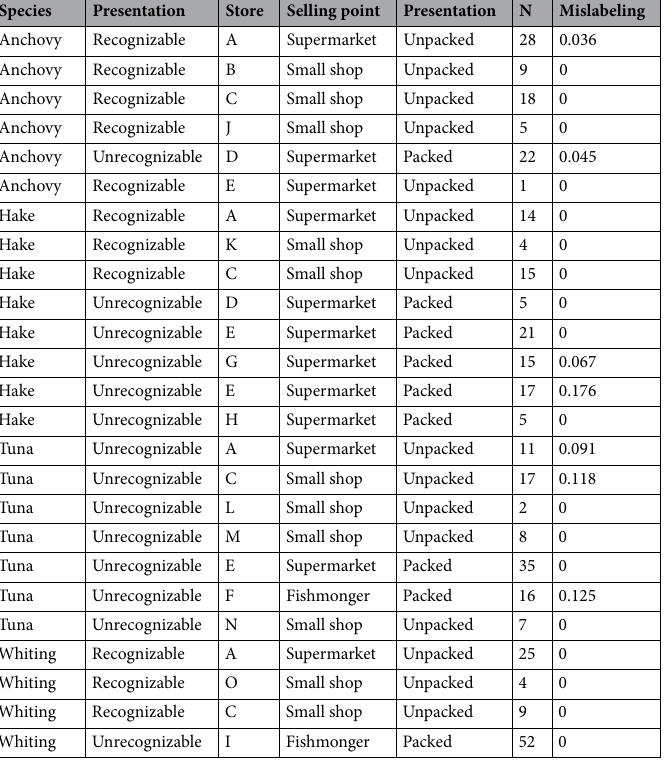
Table 1. Mislabeling found in this study. Presented by species, store, type of selling point and commercial presentation (as recognizable versus not recognizable).